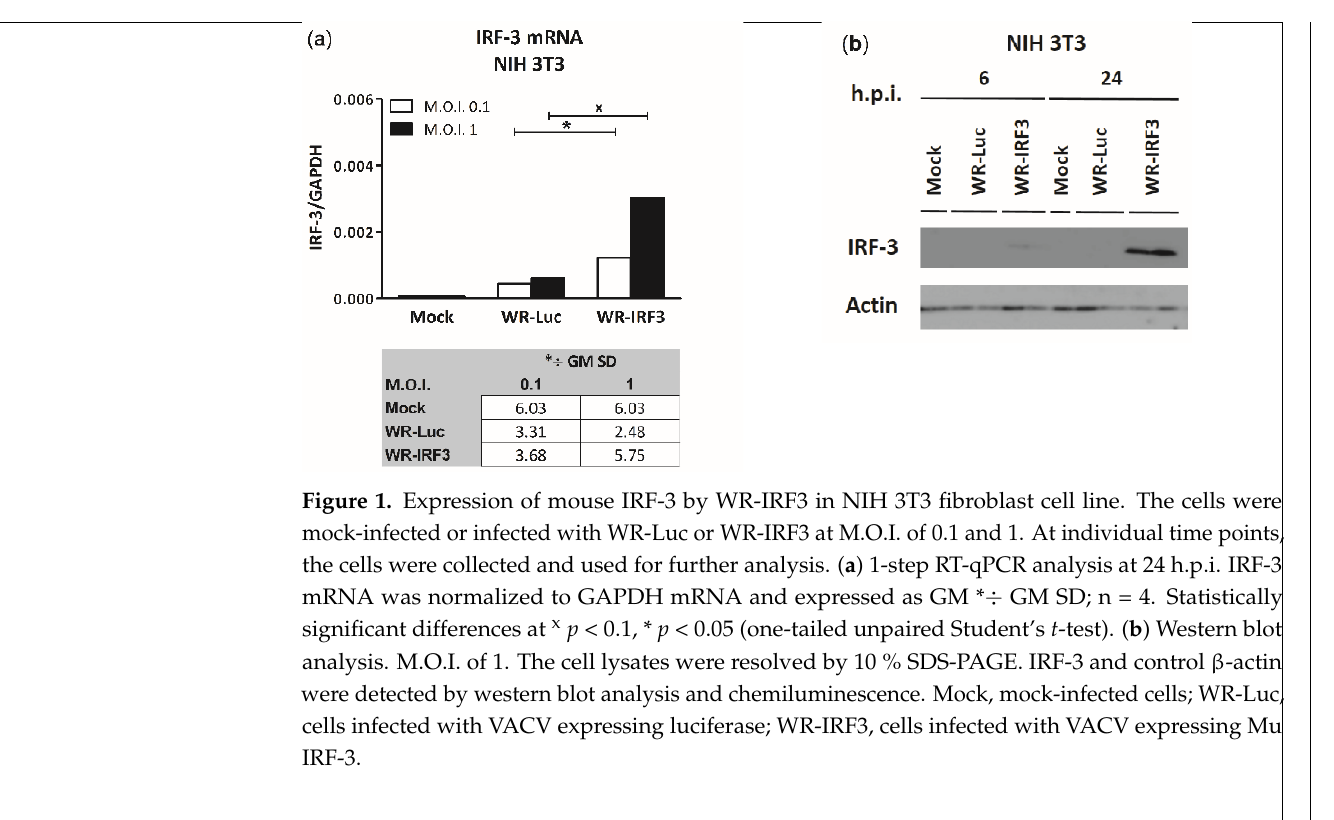
Figure 1. Expression of mouse IRF-3 by WR-IRF3 in NIH 3T3 fibroblast cell line. The cells were mock-infected or infected with WR-Luc or WR-IRF3 at M.O.I. of 0.1 and 1. At individual time points, the cells were collected and used for further analysis. ( a ) 1-step RT-qPCR analysis at 24 h.p.i. IRF-3 mRNA was normalized to GAPDH mRNA and expressed as GM